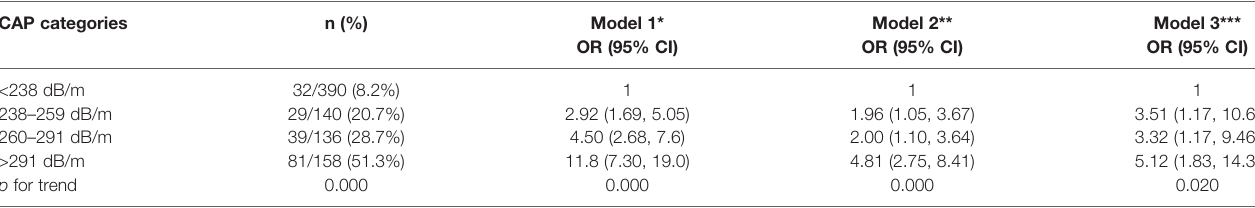
TABLE 3 | Proportion and odds ratio of having MetS according to CAP-based